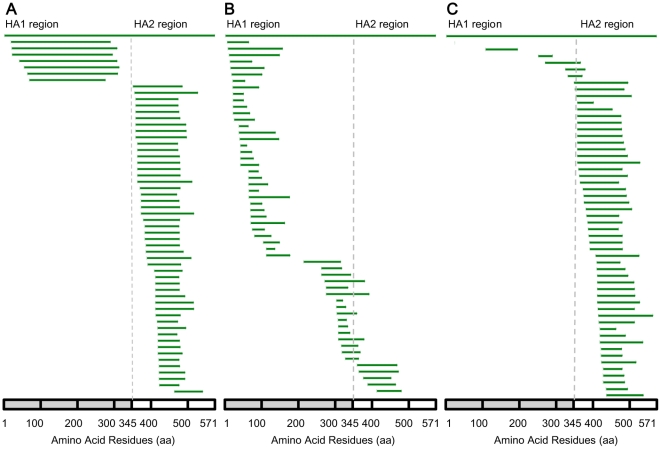
Alignment of antigenic peptide profiles derived from screening against three antiserum samples.(A) 56 peptides (with a RAYS ratio ≥2) obtained using mouse antisera (M-1 to M-56 from top to bottom). (B) 55 peptides obtained using goat antisera with the whole HA protein (G-1 to G-55 from the top to the bottom). (C) 51 peptides obtained using human plasma (H-1 to H-51 from top to bottom). The coordinates of the whole HA protein are indicated by the bars. The borders of the HA1 and HA2 regions (residue 345) are indicated by dashed lines.